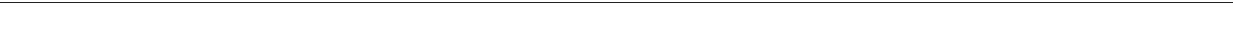
Fig. 1 Multiple manifestations of voriconazole-induced death are linked to cell wall integrity failure. a – d A . fumigatus wild-type conidia expressing mitochondria-targeted GFP were inoculated in Sabouraud medium and incubated at 37 °C. After 9 h, medium was supplemented with 0.4 µ g ml − 1 ( a ), 1.27 µ g ml − 1 ( b , c ) or the indicated amount ( d ) of voriconazole. The fate of individual hyphae was followed over time with confocal laser scanning microscopy.